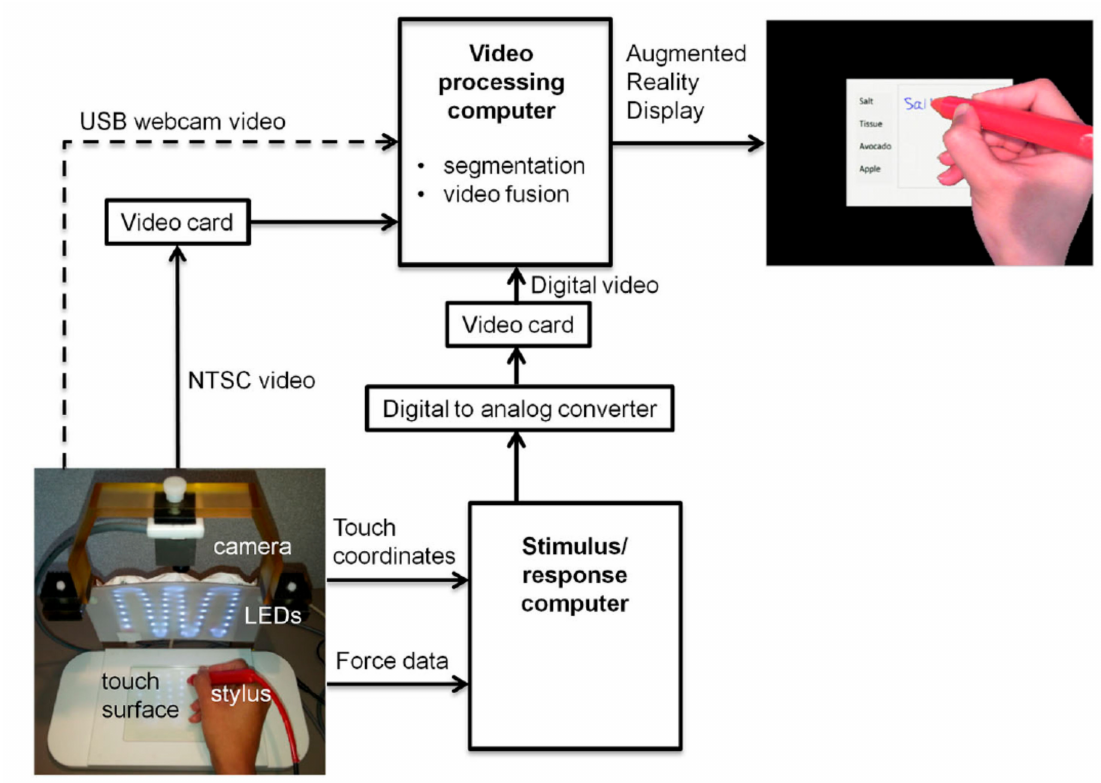
Figure 2. Block diagram for prototype 2 of the fMRI-compatible tablet system design. See text for details. USB = Universal Serial Bus; LED = Light Emitting Diode; NTSC = National Television System Committee. Taken from [17]. Copyright © 2015 Karimpoor et